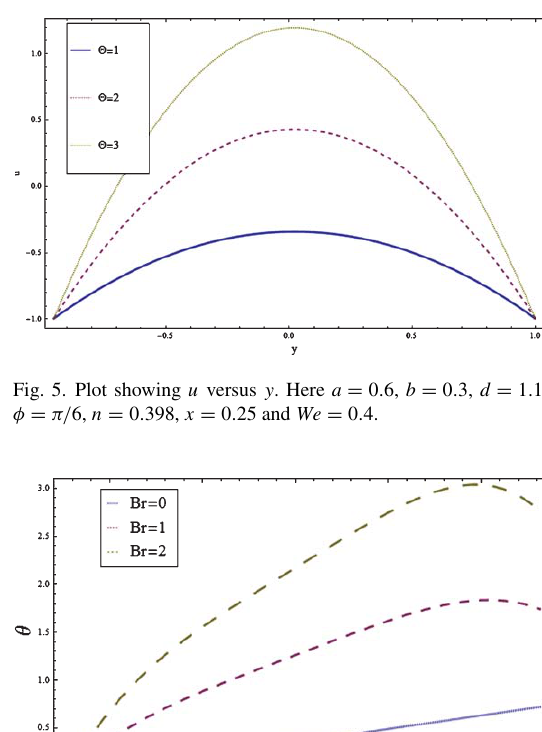
= 1, Bi = 10, x = 0 . 2 and We = 1 2